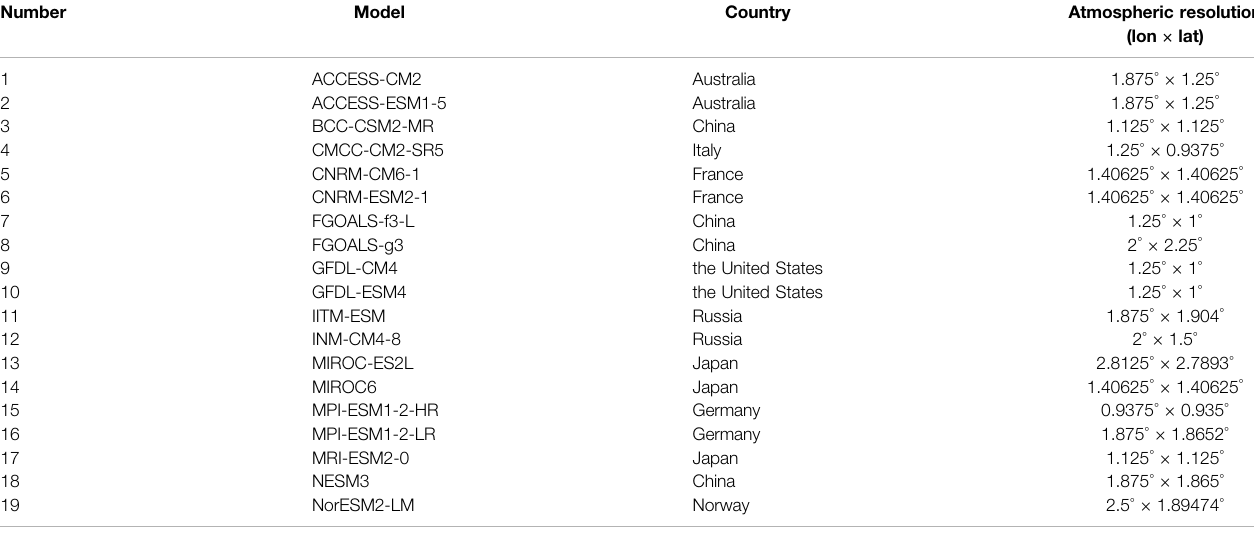
TABLE 1 | Basic information of the GCMs of the CMIP6 used in this study. The “ lon ” means longitude, the “ lat ” means latitude, the “ lon × lat ” means the spatial resolution of each model.